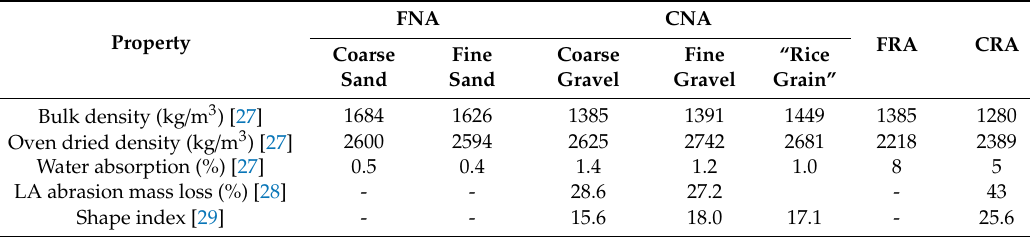
Table 2. Characterization of natural and recycled aggregates.